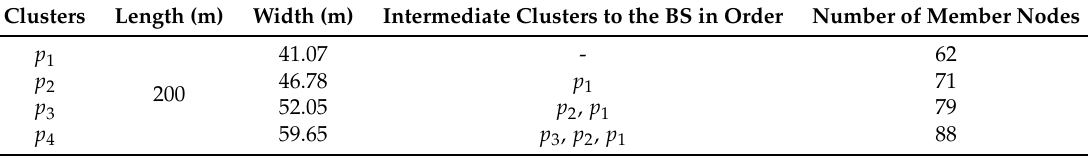
Table 3. Size of the